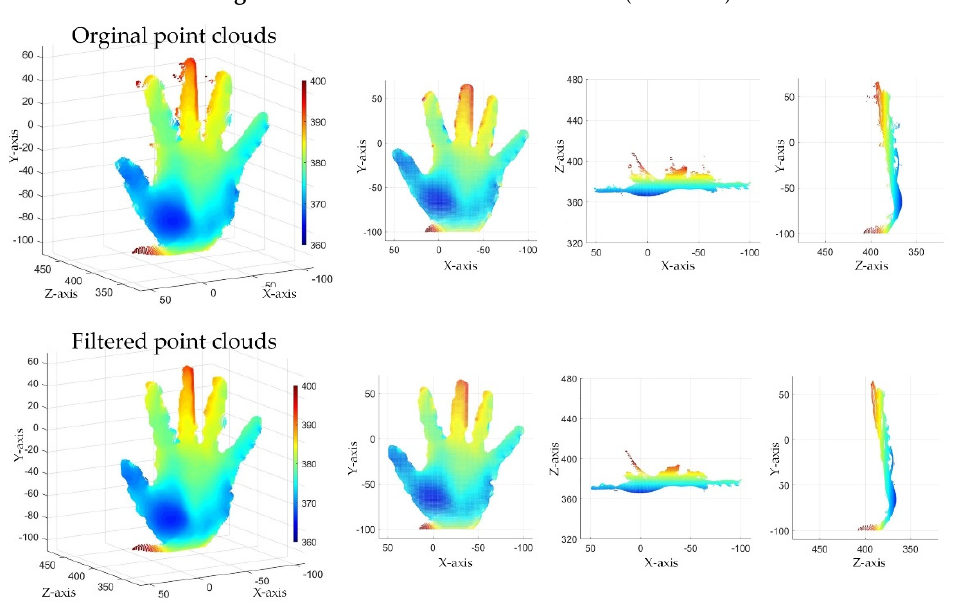
Figure 11. Three views of the filter result (SR300).